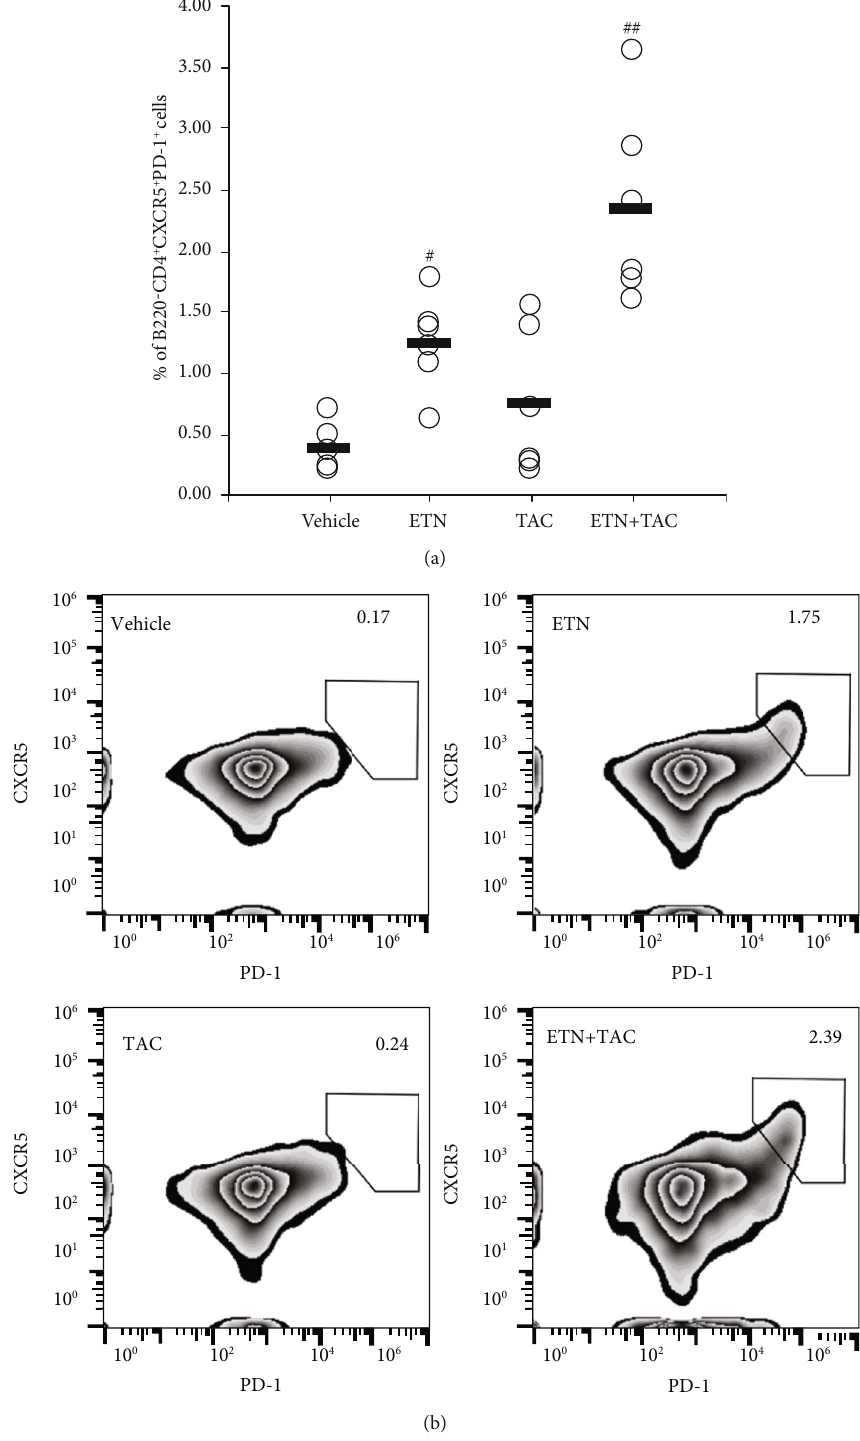
Figure 3: Etanercept increases the number of peripheral B220 − CD4 + CXCR5 + PD-1 + Tfh cells in hTNF-Tg mice. Etanercept (ETN; 4 mg/kg) was administered subcutaneously twice a week for 4 weeks, and tacrolimus (TAC; 3mg/kg) was administered orally once daily for 4 weeks. (a) Percentages of ZombieNIR-negative B220 − CD4 + CXCR5 + PD-1 + cells in splenocytes derived from individual mice are shown. Each horizontal bar shows the mean of six animals per group. # p < 0 : 05 and ## p < 0 : 01 (Steel ’ s test) compared with the vehicle group. (b) Representative plots of each drug treatment group are shown. Data are representative of two independent